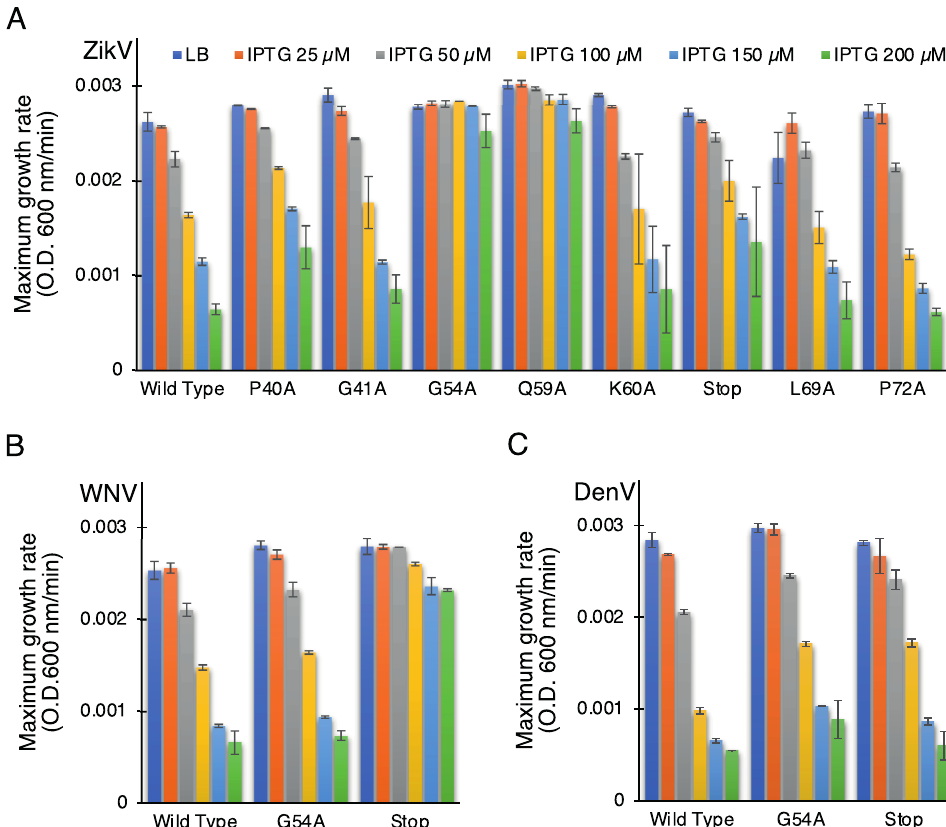
Figure 4. Effect of mutants of flavivirus membrane proteins in the negative genetic assay. Maximal growth rates of bacteria that express mutants of ZikV-M ( A ), WNV MgM ( B ), and DenV MgM ( C ) as a function of increasing IPTG, as noted.